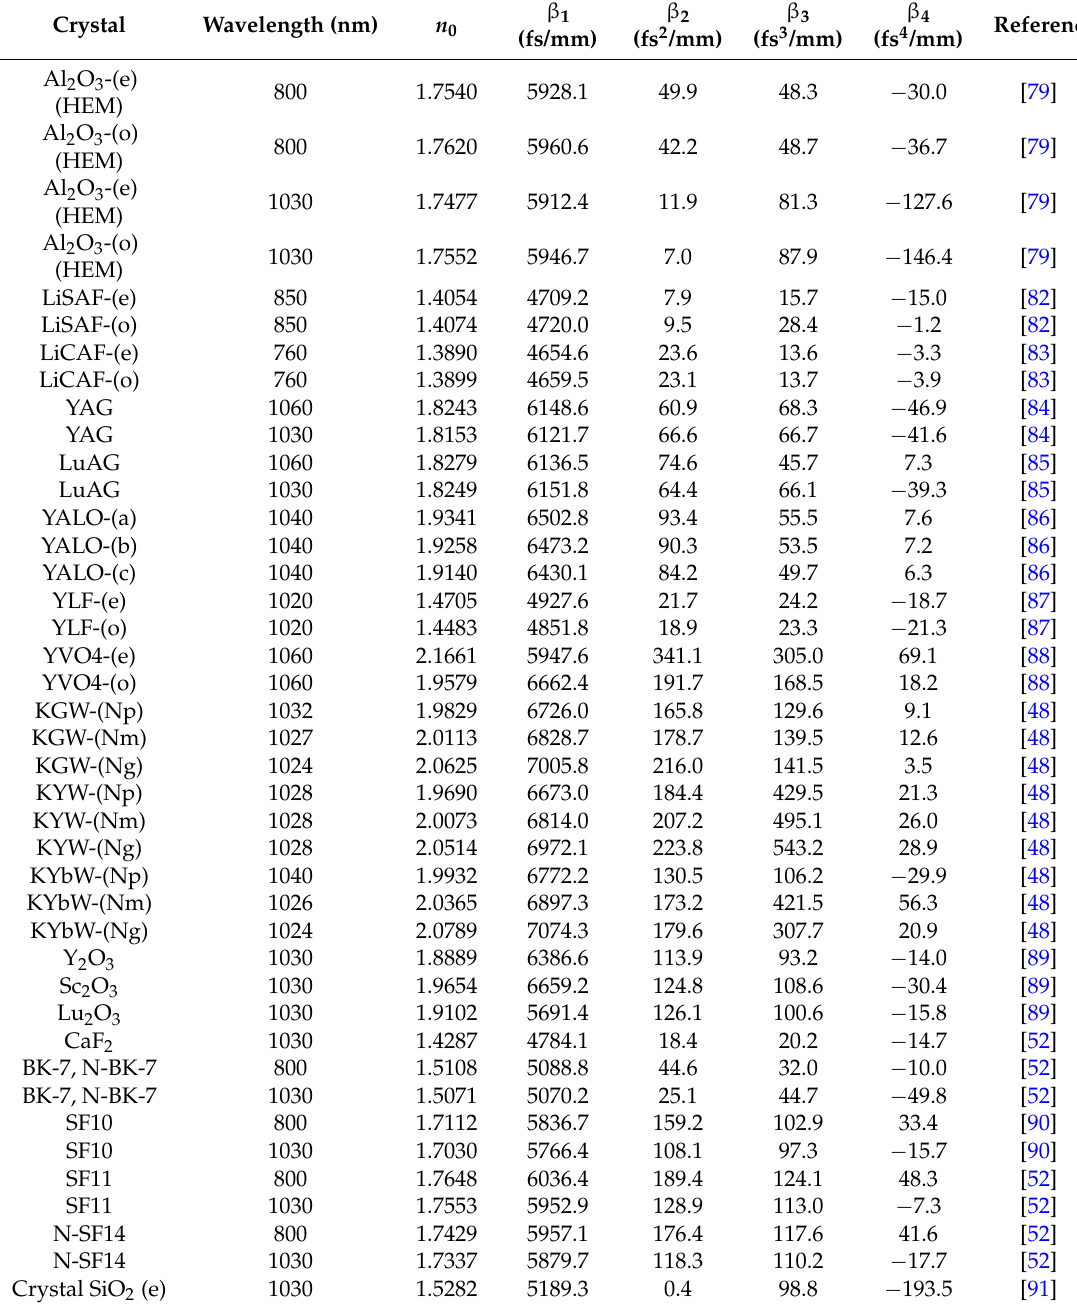
Table 5. Calculated room temperature values of the linear index and the first, second, third, and fourth order dispersion parameters for legacy and newer laser crystals of length 1 mm. Also shown are the operating laser wavelengths, as well as references to allow readers to know what Sellmeier or alternative index equation was used in the